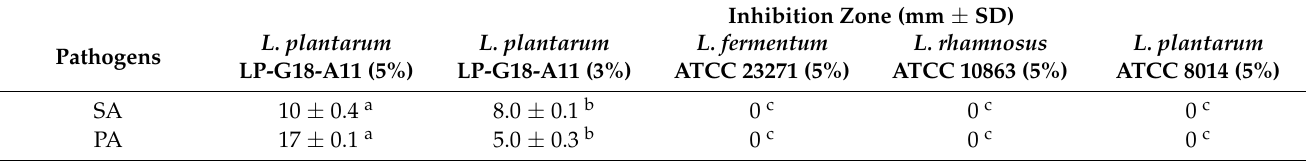
Table 2. Antimicrobial activity of natrosol gel with lactobacilli strains.